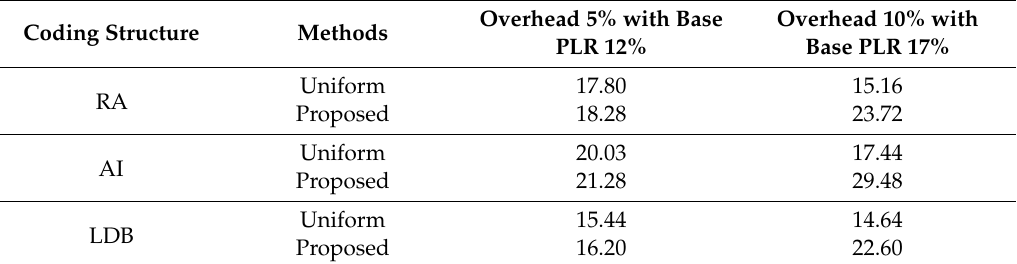
Table 2. Y-PSNR results with Raptor overhead 5% and 10%.